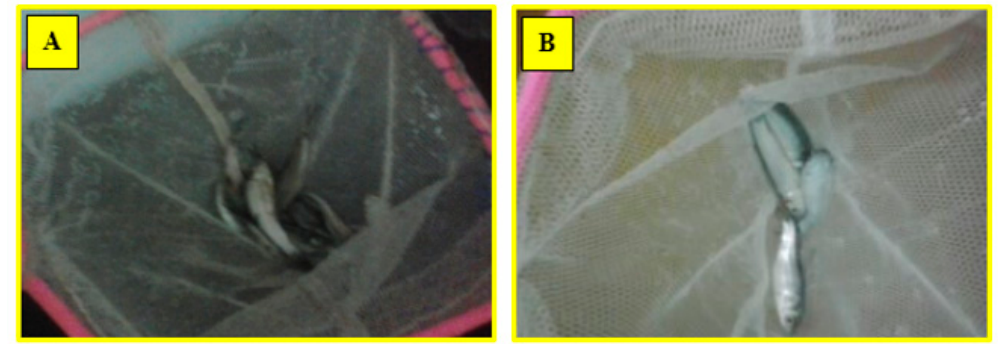
Figure 5. Morphological change in C. idella on exposure to tannery effluent before ( A ) and after treatment ( B ) by CW technology.